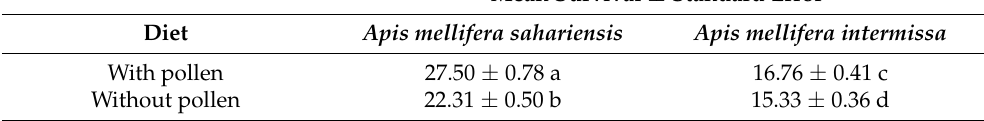
Table 1. Kaplan–Meier estimate of survival time of Apis mellifera sahariensis and Apis mellifera intermissa according to diet (pollen-fed and pollen-deprived), with confidence interval (95% CI), results expressed as (mean ± standard error), and letters indicate significant difference test (Gehan– Wilcoxon